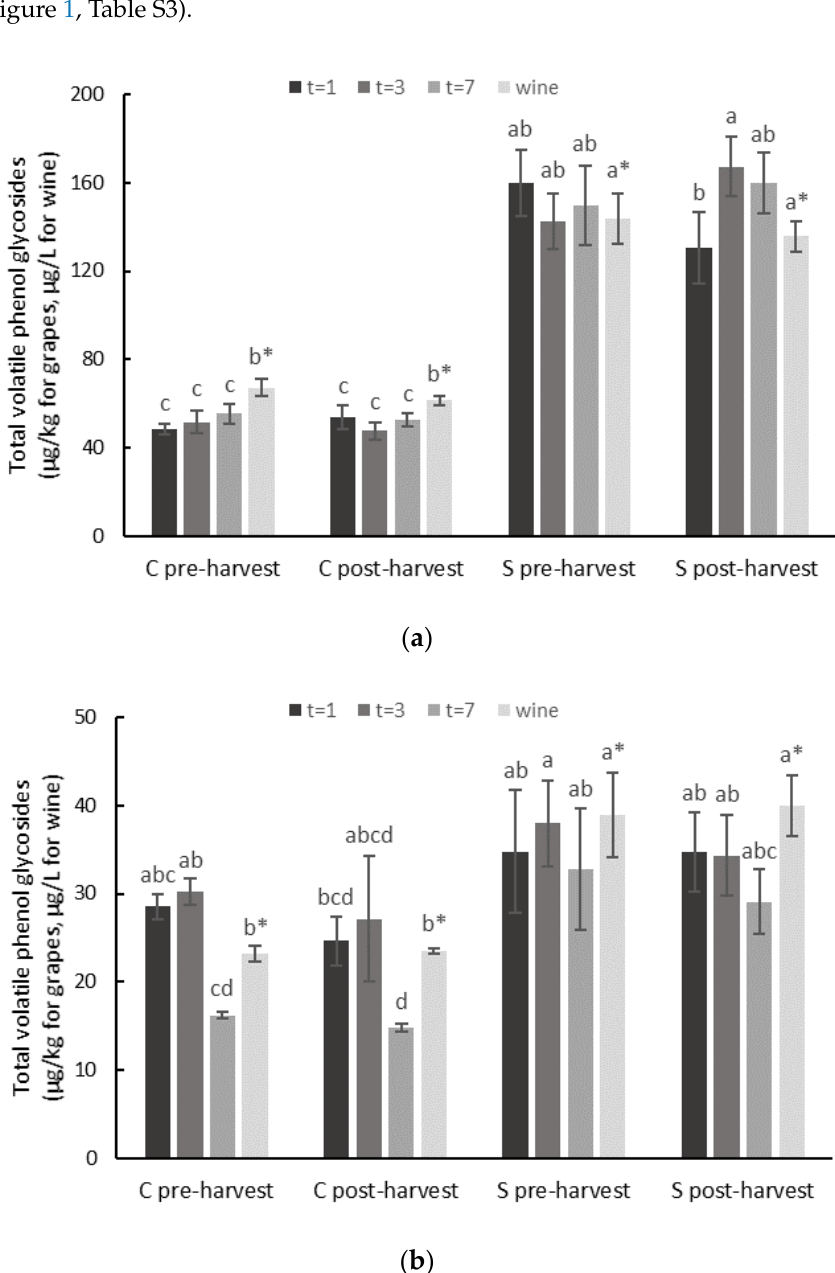
Figure 1. Total volatile phenol glycoside concentrations in control (C) and smoke-affected (S) ( a ) Viognier and ( b ) Cabernet Sauvignon grapes (in µg/kg, at 1, 3 and 7 days after smoke exposure) and wine (in µg/L). Values are means of three replicates ( n = 3) measured as syringol glucose-glucoside equivalents. Different letters indicate statistical significance ( p = 0.05, one-way ANOVA) amongst grape or wine (*) samples.